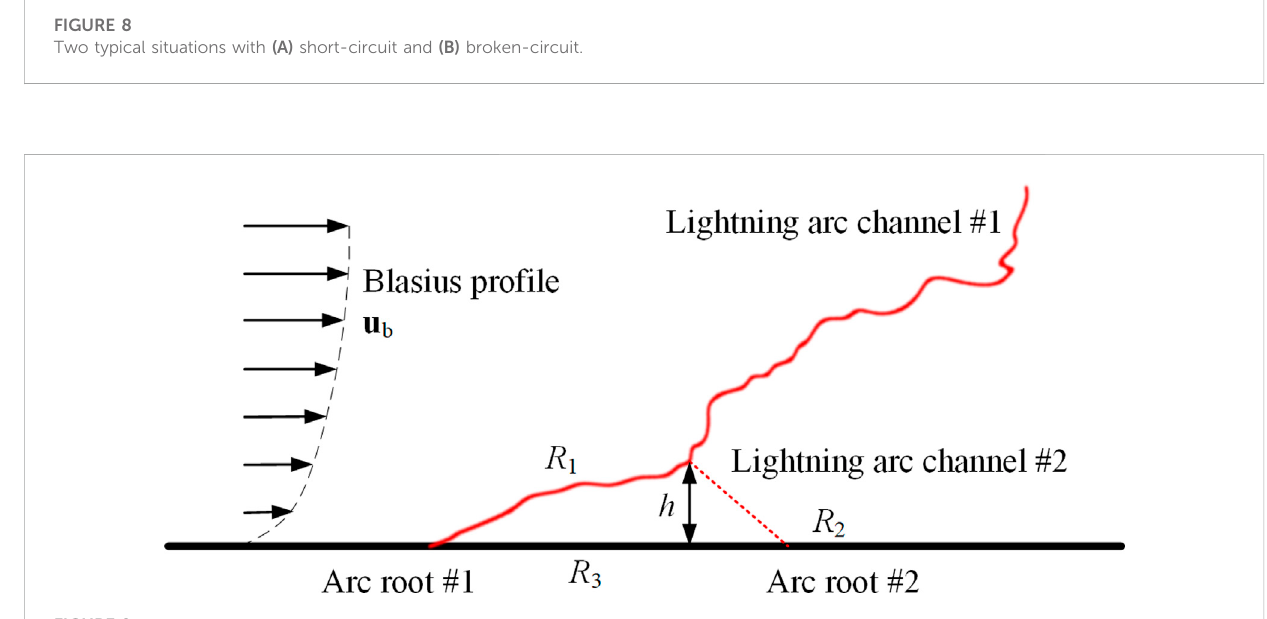
FIGURE 9 Schematic diagram of the arc root